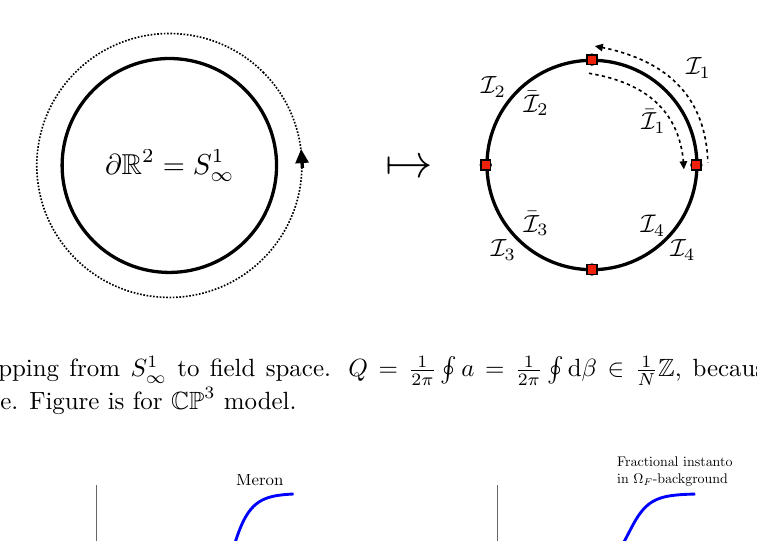
Figure 7 . Mapping from S 1 U(1) / bundle. Figure is for Z N